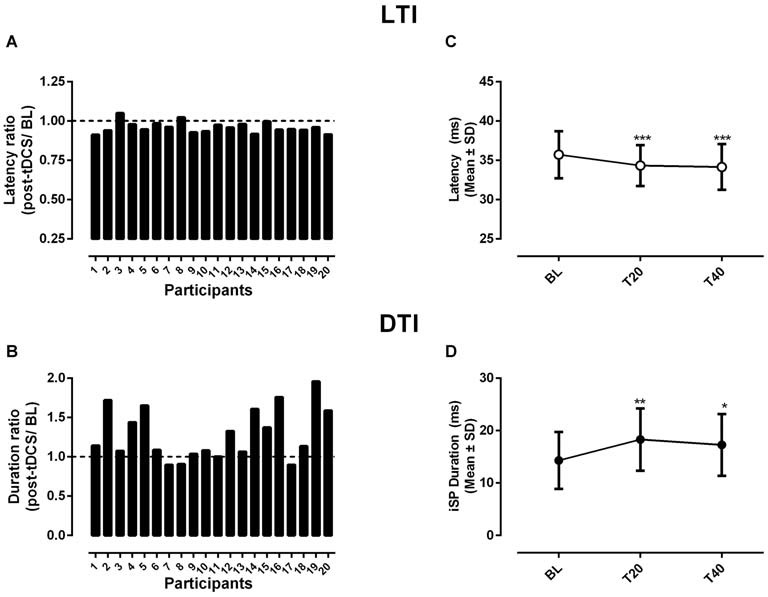
Changes in the onset latency (A,C) and in the duration (B,D) of transcallosal inhibition (respectively, LTI and DTI) in response to a-tDCS. In (A,C) changes are shown for each individual as a ratio of the grand average computed for all time points post-tDCS divided by baseline (i.e., post-tDCS/BL). The dotted lines in each graph indicate no change relative to baseline. In (B,D) the overall changes are shown as means and standard deviations computed across all participants and for each time point before (BL) and after tDCS. Note the significant changes in both LTI and DTI relative to baseline detected in post-test comparisons as indicated by the asterisks (*p < 0.05, **p < 0.01, ***p < 0.001).